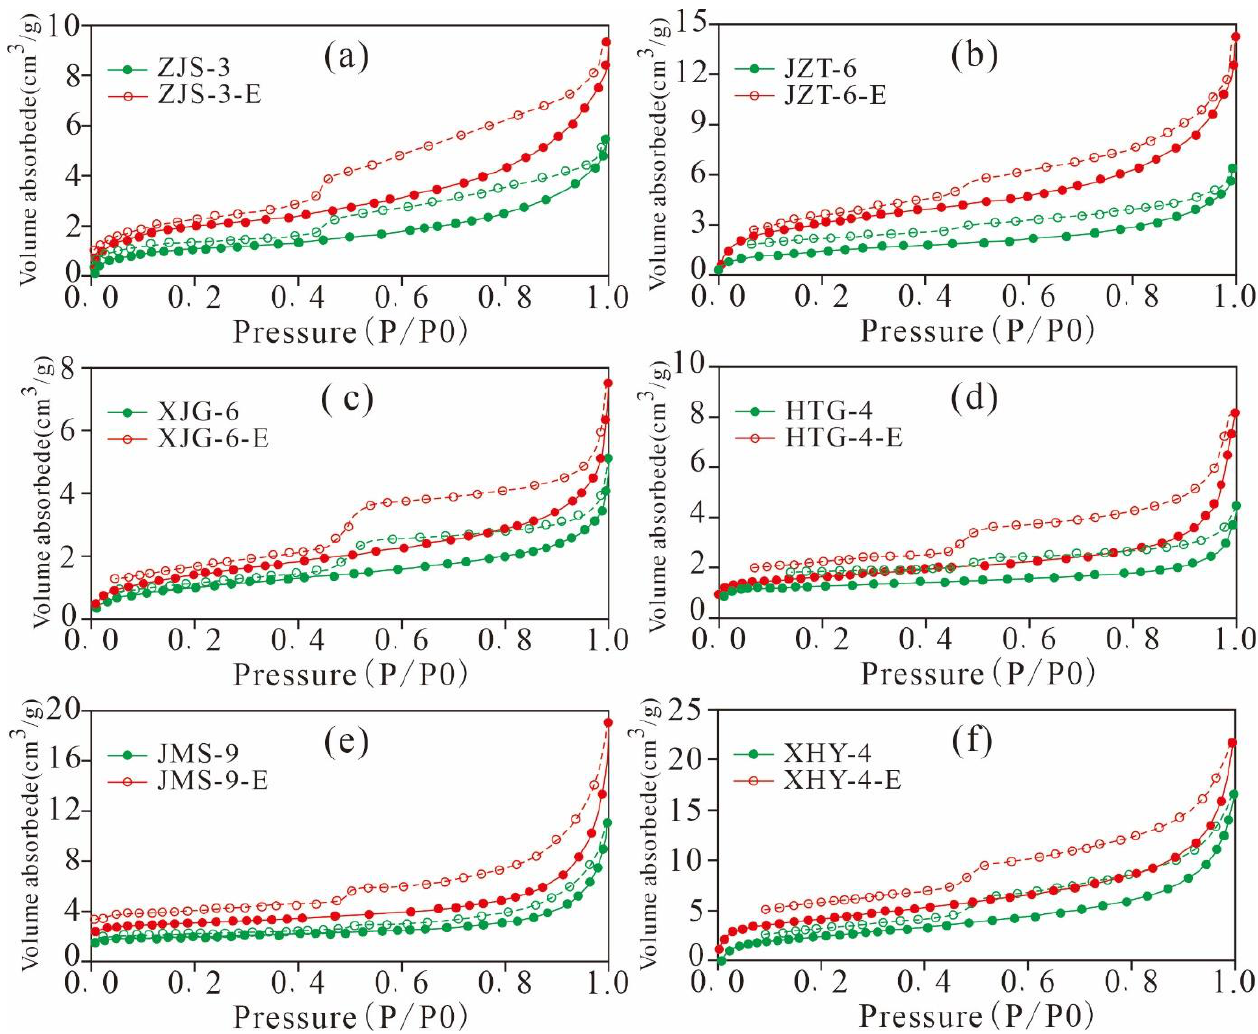
Figure 17. N 2 adsorption and desorption isotherms of the original shale and extracted shale (( a ), ZJS-3; ( b ), JZT-6; ( c ), XJG-6; ( d ), HTG-4; ( e ), JMS-9; ( f ), XHY-4).